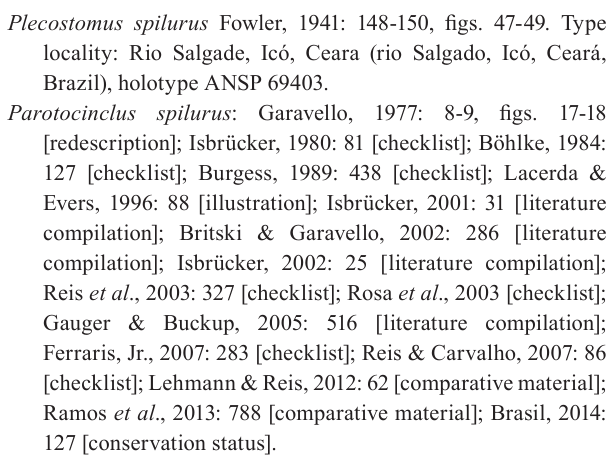
Plecostomus spilurus Fowler, 1941: 148-150, figs. 47-49. Type locality: Rio Salgade, Icó, Ceara (rio Salgado, Icó, Ceará, Brazil), holotype ANSP